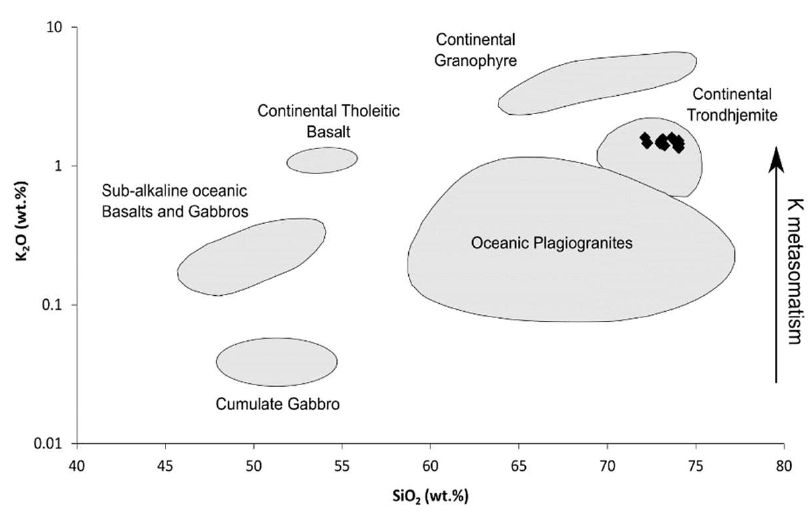
Figure 7. SiO 2 (wt.%) vs. K 2 O (wt.%) variation diagram. All studied leucocratic rocks samples fall in the continental trondhjemite field. Modified after [56].